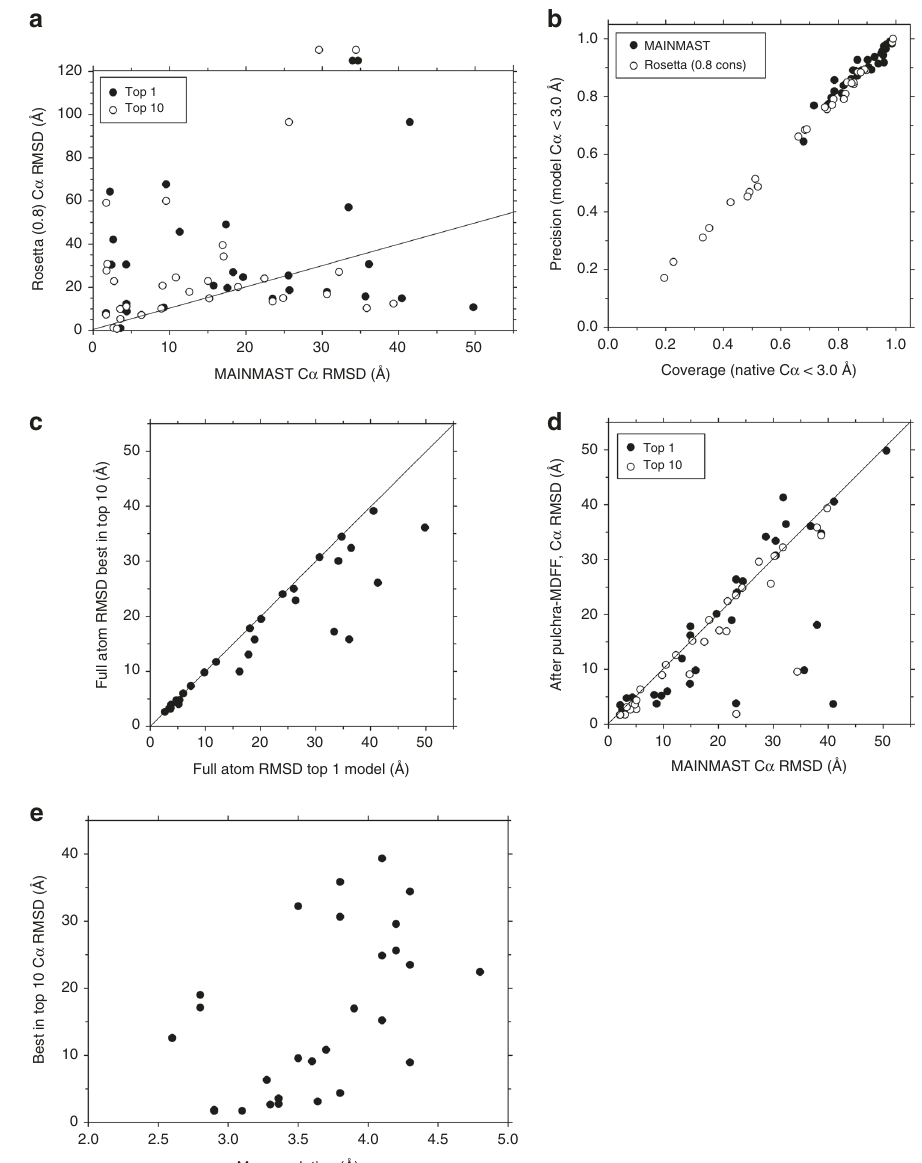
Fig. 3 Modeling results of the 30 experimental EM maps by MAINMAST. a C α RMSD of the top scoring (solid circles) and the best RMSD model among the top 10 scoring models (empty circles) by MAINMAST in comparison with the Rosetta top scoring models. The re fi nement by Pulchra and MDFF were applied to the models. For Rosetta, results using 0.8 for the consensus fraction was used, because it showed better results than the default setting (Supplementary Fig. 3). The points above the frame indicate that Rosetta could not model these proteins while MAINMAST made full models at the RMSD values. b Comparison between MAINMAST and Rosetta (with a 0.8 consensus setting) in terms of coverage and precision of models. Coverage (precision) is de fi ned as the fraction of C α atoms in the native structure (the model) which are closer than 3.0 Å to any C α atoms in the model (the native structure). c Comparison between the top scoring (Top 1) model and the best RMSD model among the top 10 scoring model for each of the 30 EM maps. d Comparison of MAINMAST models before and after the re fi nement by Pulchra and MDFF. Models before the re fi nement were selected by the threading score while the scoring function of MDFF was used after the re fi nement. e RMSD of the models (the best among the top 10 socring models) by MAINMAST after re fi nement relative to the map top 1 model of F420-reducing hydrogenase α subunit (EMD- color code of this region is blue, indicating that this conformation 2513, the density map determined at a 3.36 Å resolution) and was not supported by many alternative models. In contrast, high rotavirus VP6 capsid protein (EMD-6272, the map at 2.6 Å consensus regions (orange) are indeed well modeled as shown in resolution), respectively, with a color code showing the degree of the right window. Regarding the model built from EMD-6272 consensus among top 100 scoring models. The protein of EMD- (Fig. 5b), the consensus color code indicates that the domain on 2513 was modeled at an RMSD of 3.8 Å, which implies the the right is better modeled than the left domain. This is actually modeling was reasonably successful overall; however, when the case as the left domain in blue has incorrect connections in its β -sheet as shown in the magni fi ed window, while the right examined closely, the topology of the N-terminus was incorrectly traced as shown in a magni fi ed window on the left. The consensus domain with a higher consensus has nicely modeled helical